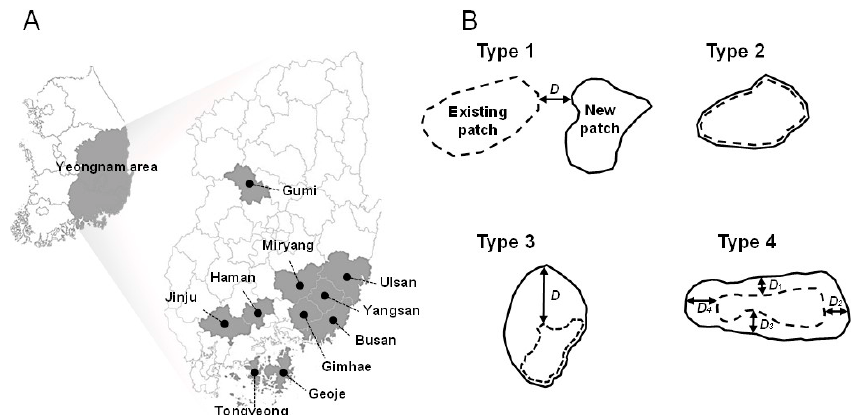
Figure 1. ( A ) Survey areas and ( B ) schematic diagrams for four dispersal types of pine wilt disease (PWD). D is the annual dispersal distance of PWD. Type 1: a jumping dispersal from a patch forming a new patch; type 2: without any dispersal; types 3 and 4 are respectively unidirectional and multi-directional dispersals expanding from an existing patch. Dispersal distance of type 4 is a mean of four Ds D1–D4.